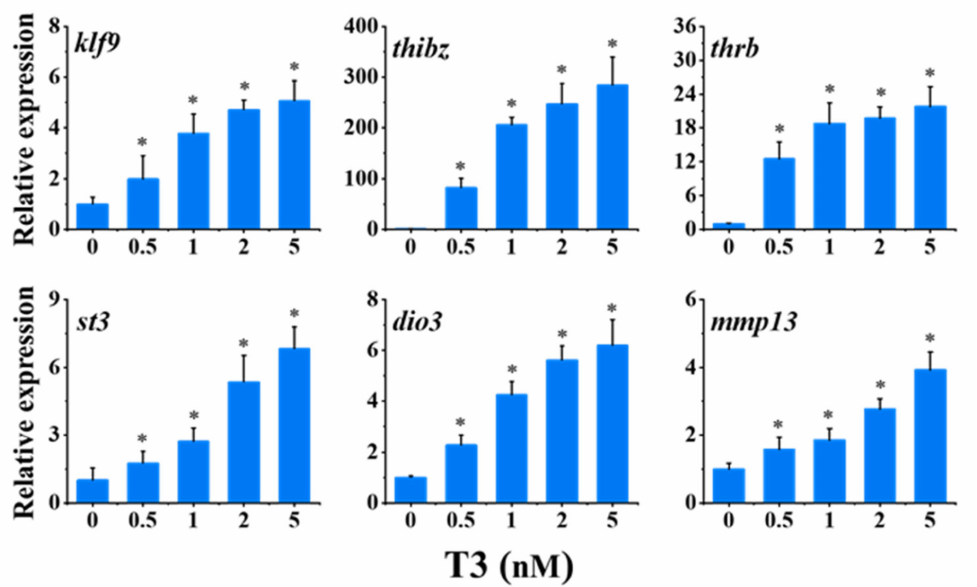
Figure 1. Relative expression of thyroid hormone (TH)-response genes in stage 48 Xenopus tadpoles following 24-h exposure to T3. Data are shown as mean ± SEM ( n = 3). * indicates significant differences between T3 exposure and the control ( p < 0.05). klf9: Kruppel-like factor 9; thibz: thyroid hormone induced bZip protein; thrb: thyroid hormone receptor beta; st3: stromelysin-3; dio3: type 3 deiodinase; mmp13: matrix metallopeptidase 13